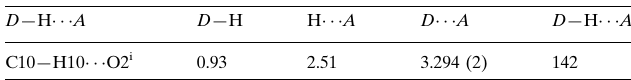
Hydrogen-bond geometry (A˚ , (cid:1)